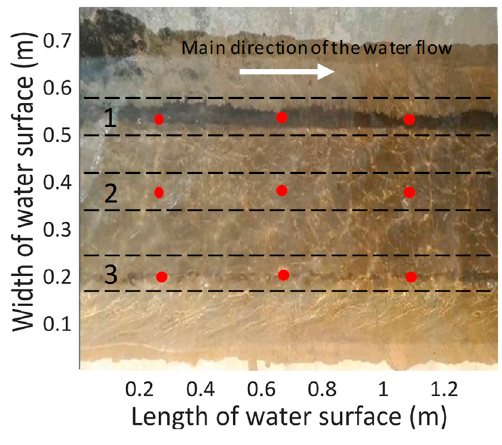
Figure 2. Flow velocity measurement sketch.